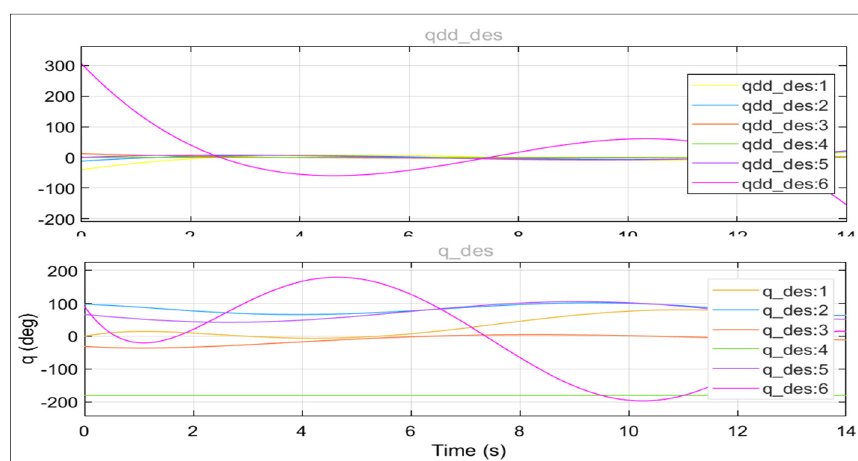
Fig. 15. Desired Joint and Acceleration/ reference